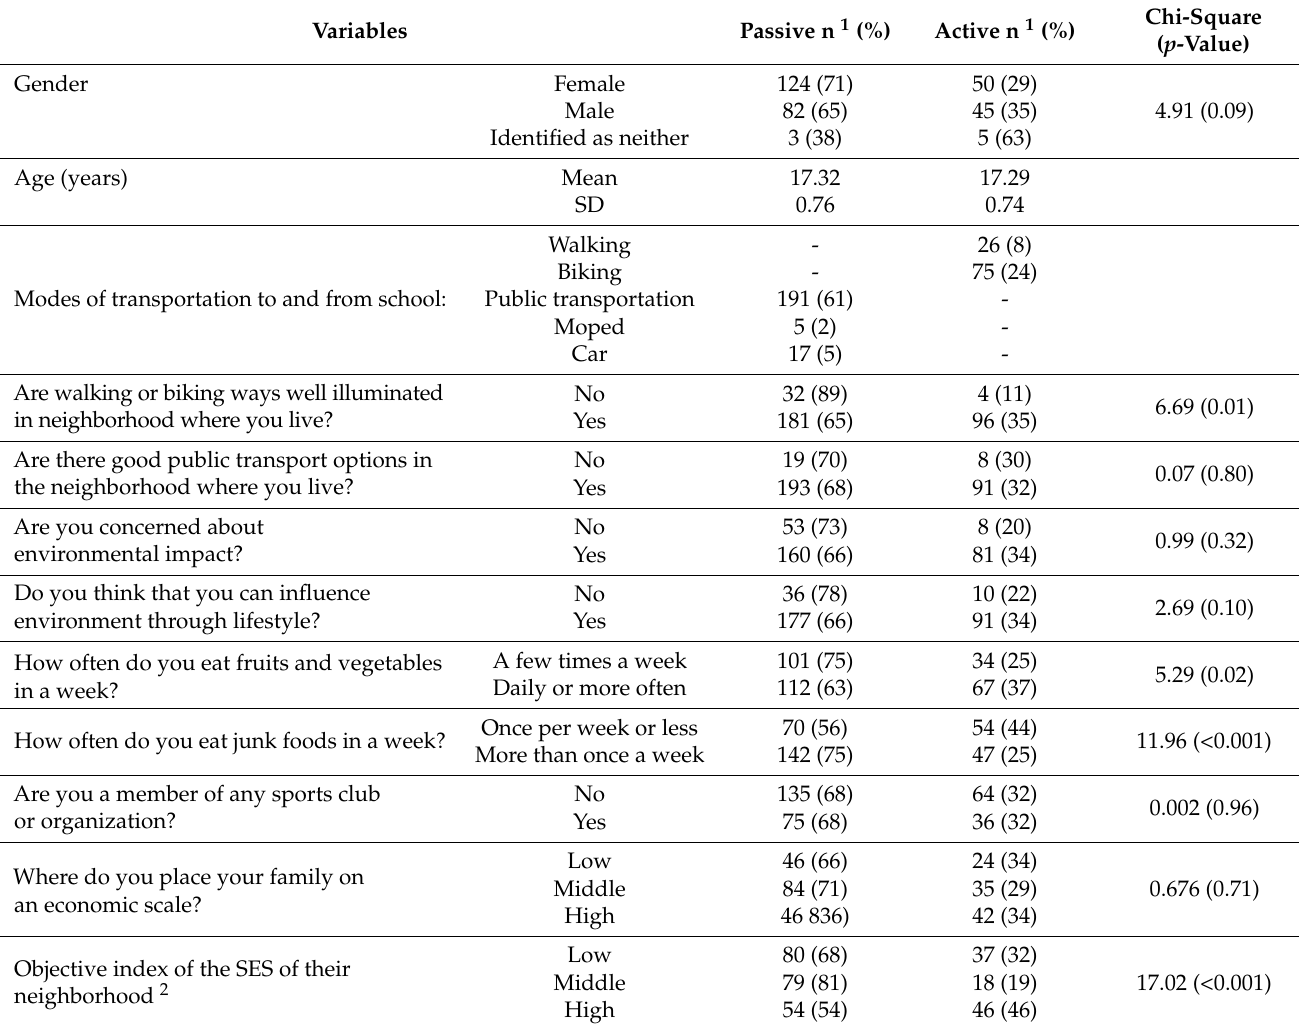
Table 2. Characteristics of adolescents in the NESLA study divided by active and passive commuters ( n = 314).